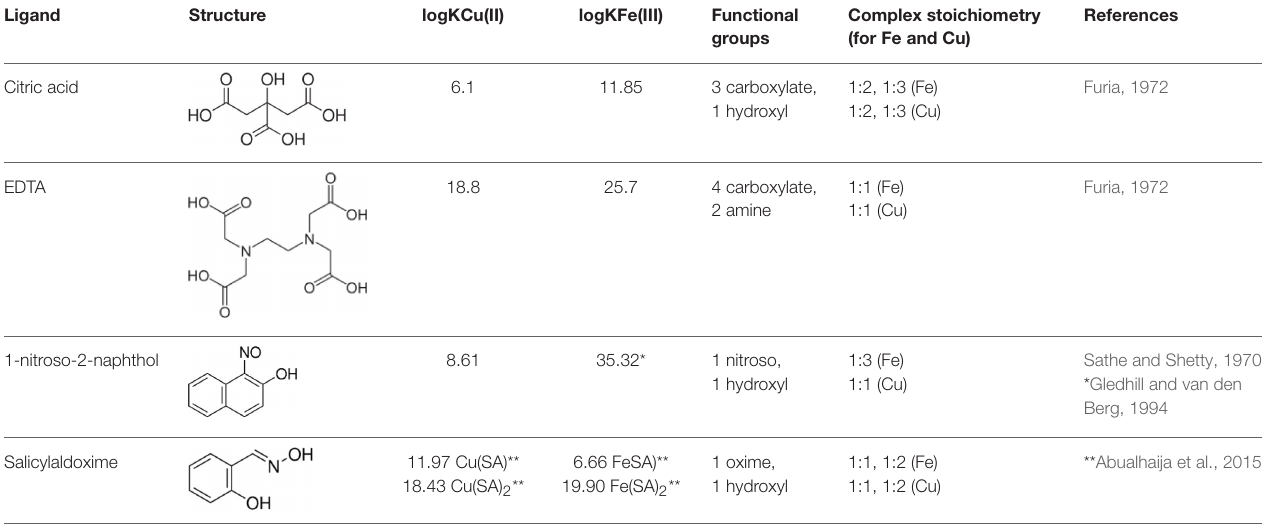
Complex stoichiometry groups (for Fe and